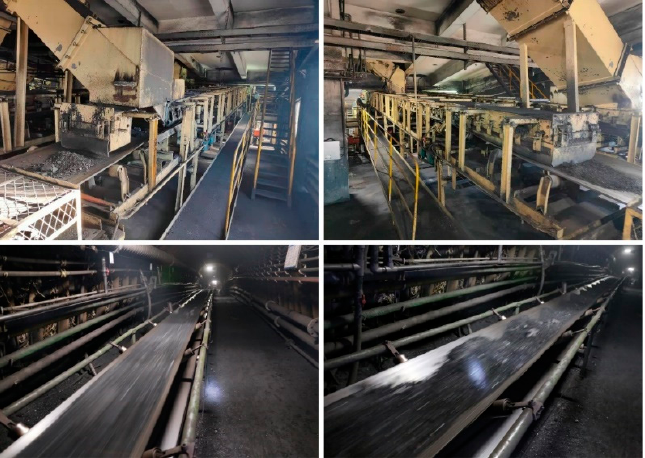
Figure 10. The application of the belt damage detection system.